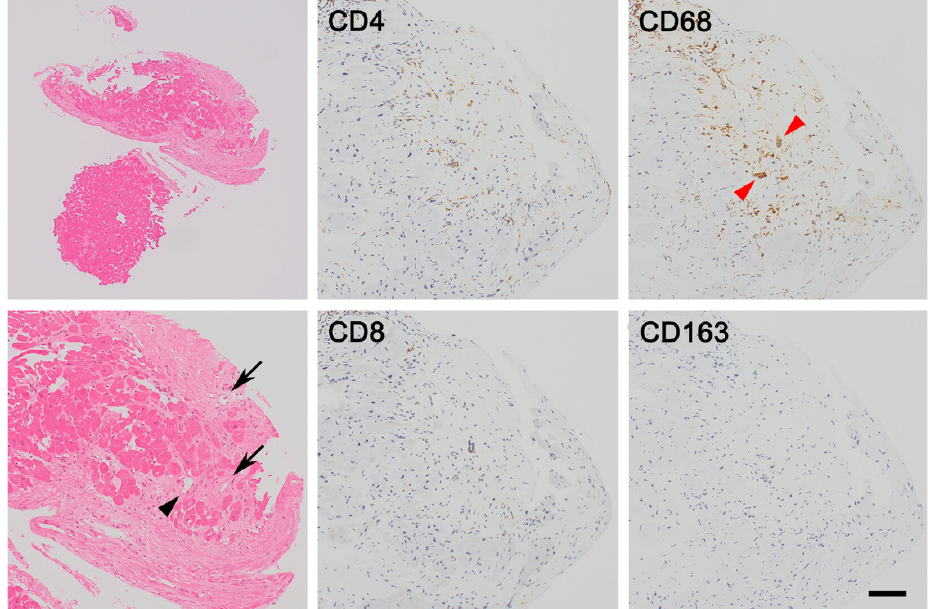
Figure 2. Interstitial phase of cardiac sarcoidosis (histiocytic myocarditis). Endomyocardial biopsy shows that macrophages accumulate sparsely as well as a few lymphocytes infiltrating in the lesions where cardiomyocytes have disappeared. As seen in this case, it is difficult to diagnose interstitial phase of cardiac sarcoidosis because apparent sarcoidal granulomas are seldom observed. However, the morphological findings, such as lymphangiogenesis (arrows), fatty infiltration (black arrow- head), and microgranulomas (red arrowheads), and the immunohistochemical results including high CD4/CD8 T-cell ratio and CD68 + CD163 − M1 macrophage phenotype are suggestive of cardiac sarcoidosis. Bar = 250 μ m for a lower magnification field, 100 μ m for higher magnification fields.